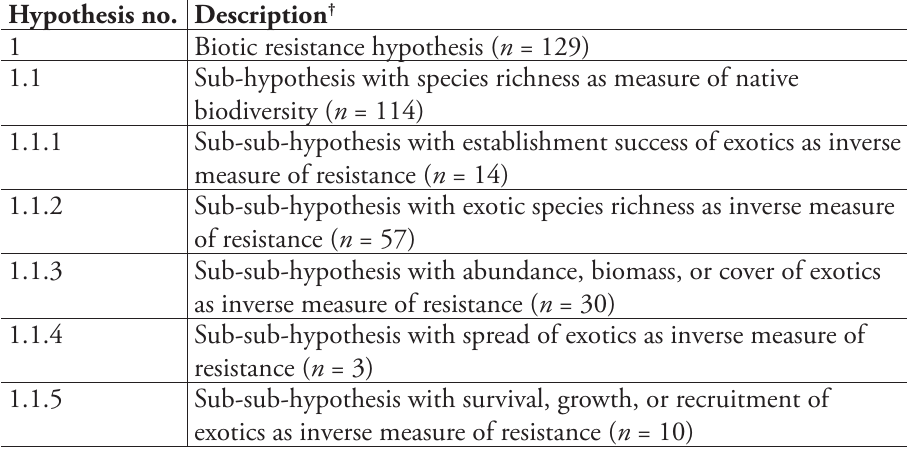
table 2. All hypotheses and sub-hypotheses evaluated in this